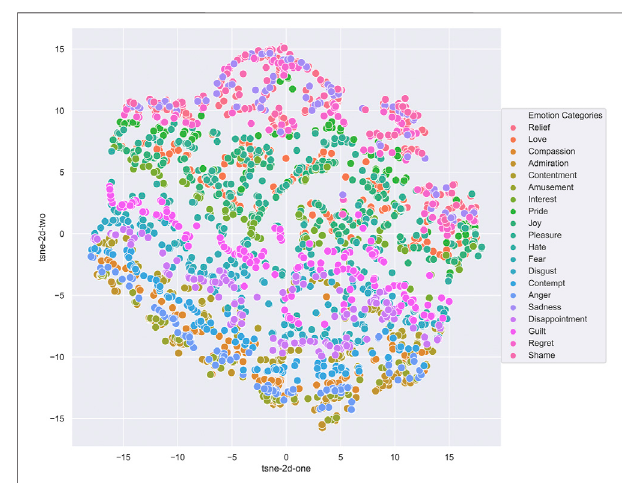
FIGURE4| VanillaVAELatentSpace,classifyingCarter ’